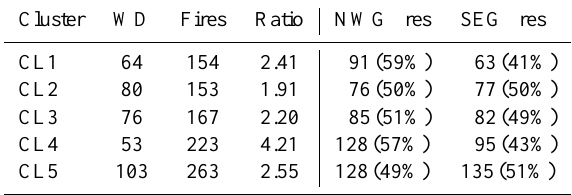
Table 7. WD and fires by